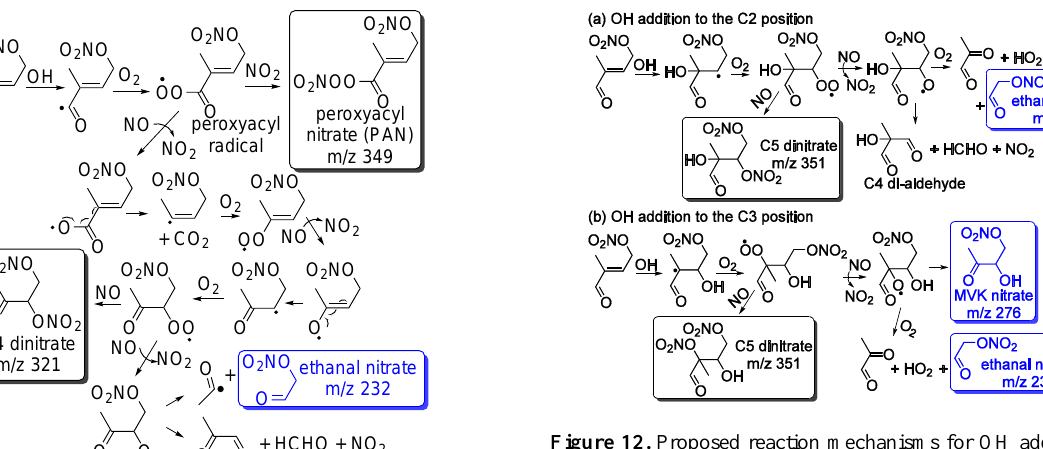
Figure 12. Proposed reaction mechanisms for OH addition to the C2 (a) and C3 (b) position of the nitrooxy enal. The compounds in boxes are products inferred from the nominal masses observed by the CIMS (Fig. 8). The compounds that were observed by both CIMS and GC (Fig. 13) are colored in